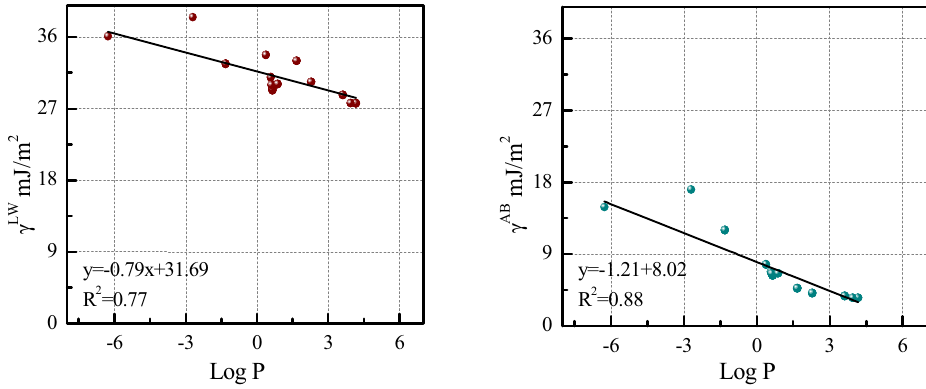
Figure 4. The Van der Waals free energies (γ LW , mJ/m 2 ) and acid–base free energies (γ AB , mJ/m 2 ) of coating compounds versus log ( K ow or P ) of coating